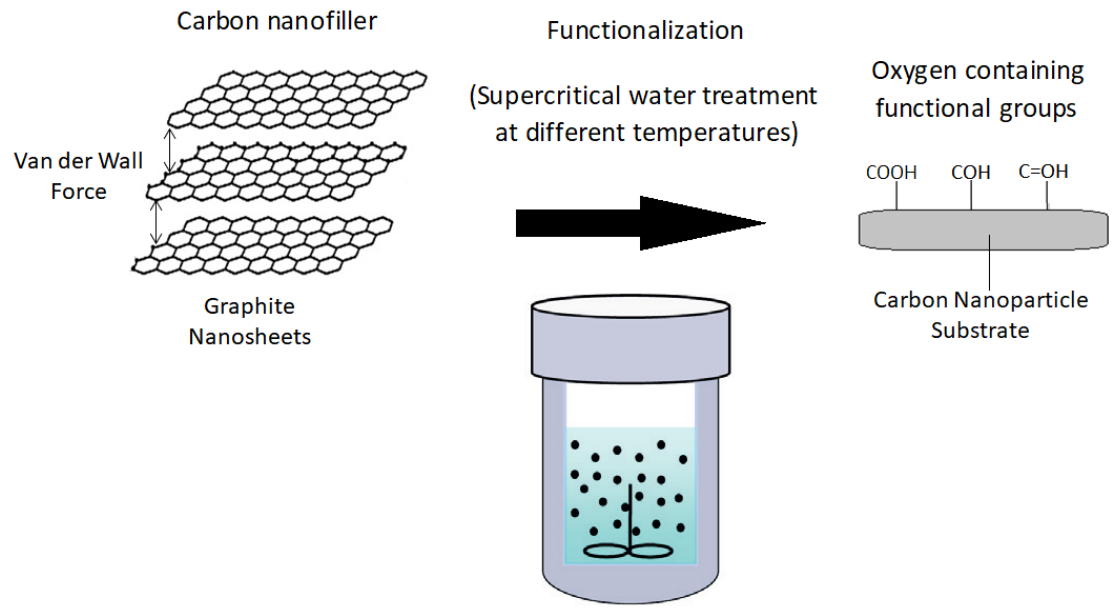
Figure 1. Supercritical Water Treatment Process of Graphite Nanosheets .